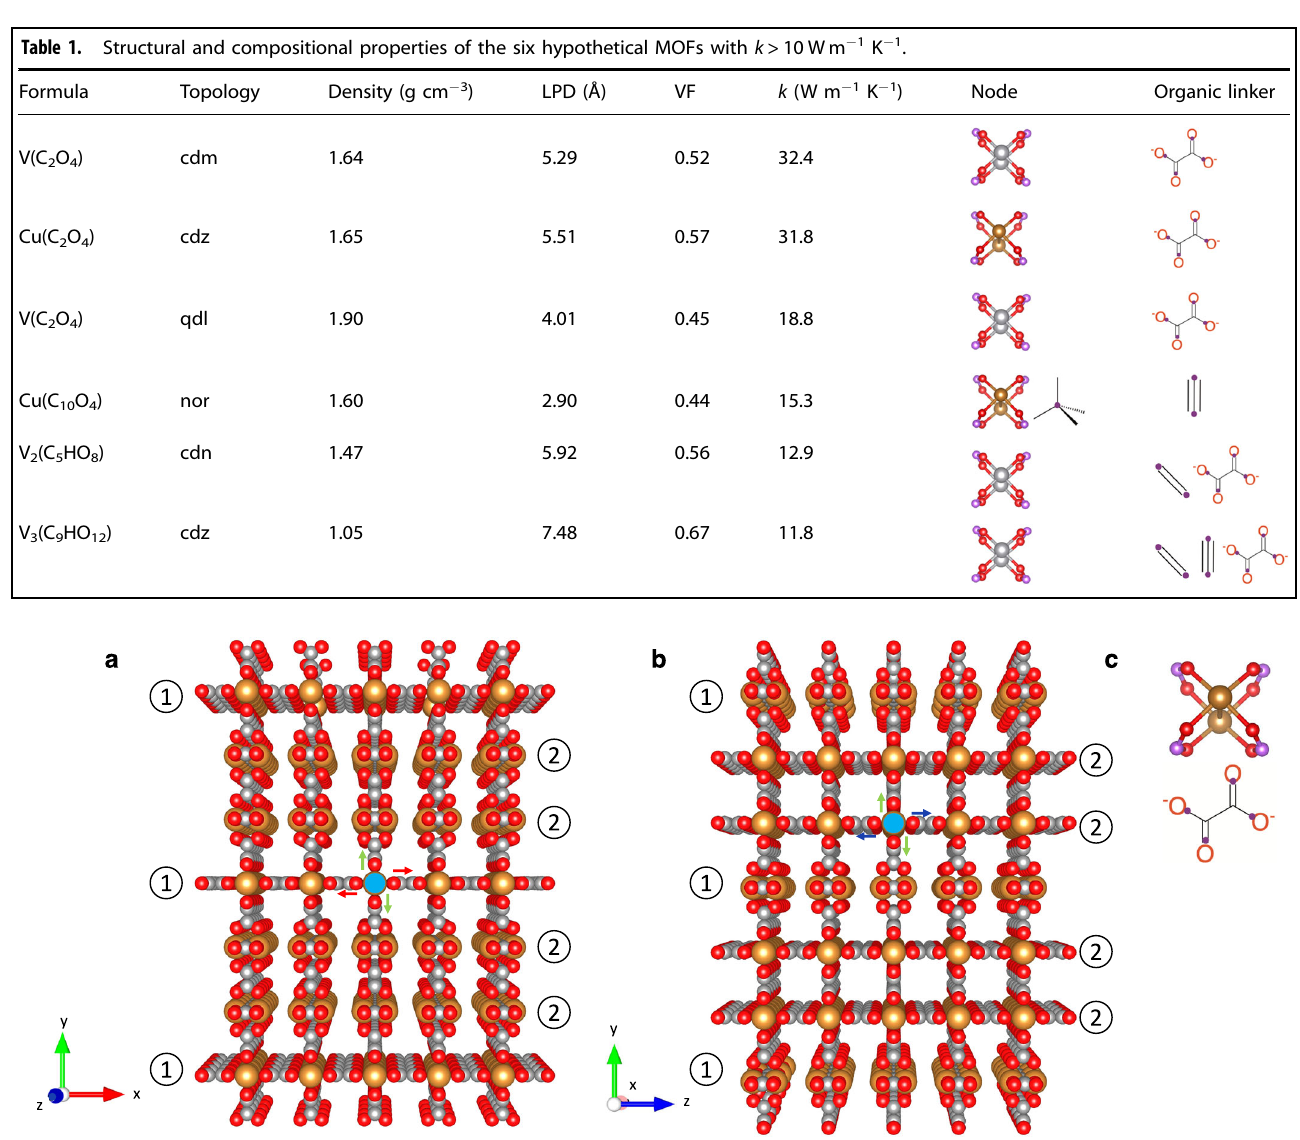
Fig. 8 Cross-sectional views of the ultra-high thermal conductivity MOF structure (cdz topology). The color scheme for the atoms is as follows: copper (gold), oxygen (red), carbon (dark grey); Panel ( b ) is ( a ) rotated clockwise by 90 degrees around the y -axis. The circled 1 and 2 represents the xz planes. c building blocks: a Cu(II)-paddlewheel metal node and an oxalate linker. The connecting points to other building blocks are represented with violet circles.